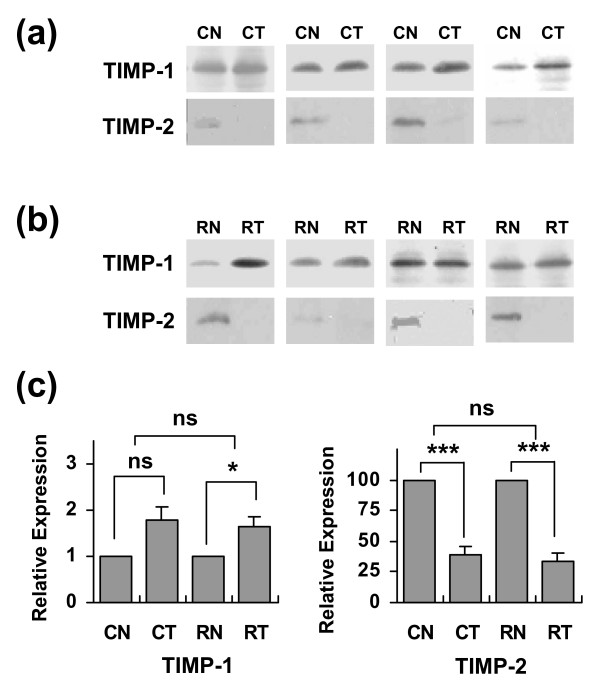
The expression of TIMP-1 and TIMP-2 in tumortissues and adjacent normal mucosa of colon and rectal cancer patients. (a) Representative Western blot analysis of colon tumor (CT) and the corresponding paired adjacent normal colonic mucosa (CN) from colon cancer patients. (b) Representative Western blots of rectal tumor (RT) and the corresponding paired adjacent normal rectal mucosa (RN) from rectal cancer patients. (c) Band densities from all tissue samples were quantified, and the relative expression of TIMP-1 and TIMP-2 are expressed as a mean ± SE. ns, non-significant. *P < 0.05. ***P < 0.001.